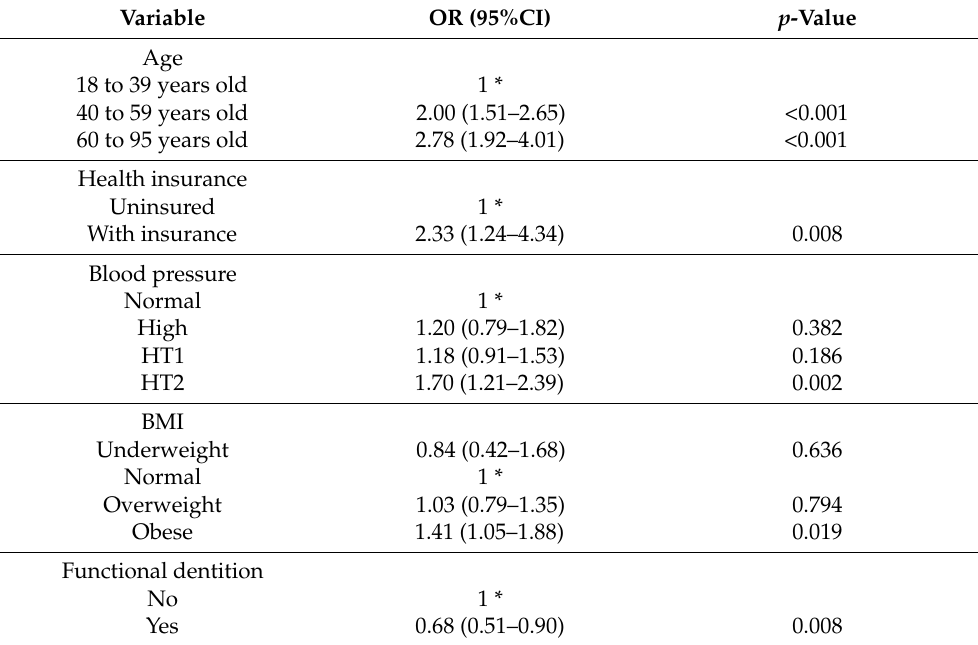
Table 3. Multivariate logistic regression analysis for diabetes and independent variables included in the